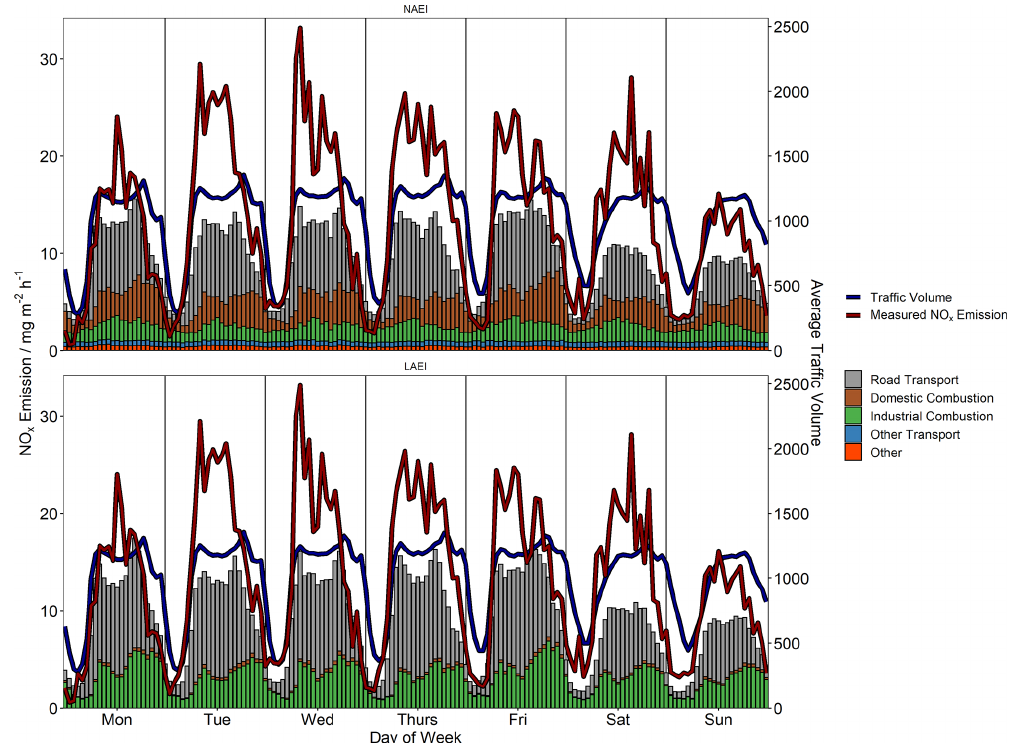
Figure 9. Average diurnal profiles of NO x emissions measured (red) at the BT Tower in March–July 2017 and the NAEI’s estimated emission (bars) from within the flux footprint, separated by day of week. NAEI emissions are coloured by source sector contribution. Median traffic volume from 24 automatic traffic counters surrounding the site is shown in blue.